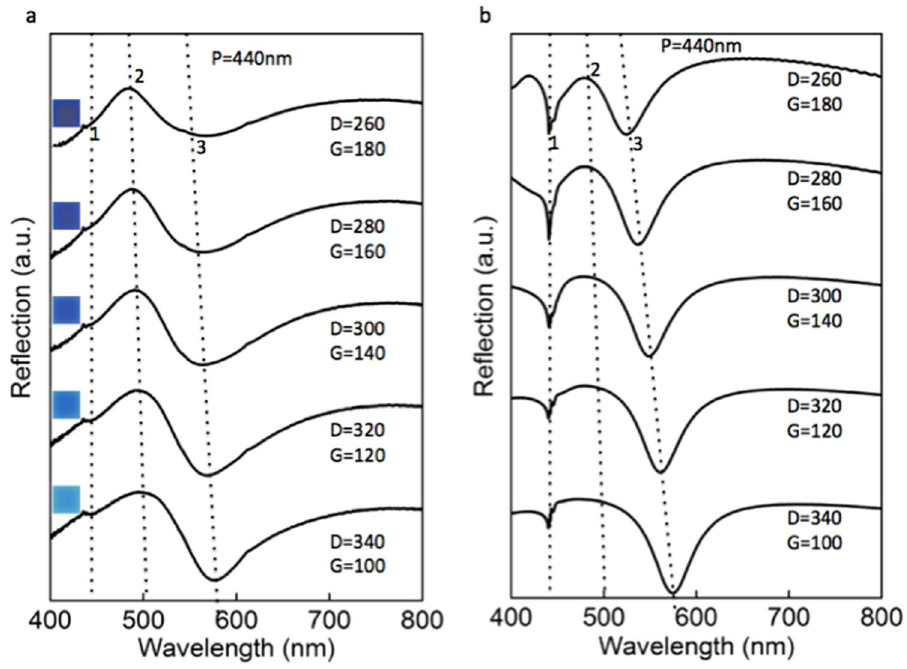
Figure 4. Tuning the colour saturation. ( a ) Experimental reflectance of the structures of same P with varying G and D. The gap size G was varied from 100 nm to 180 nm with an increment of 20 nm within the same pixel size P of 440 nm. Increasing G effectively reduces the square size D keeping P constant. As indicated by the dashed lines the resonance Dip2 at position 3 shifts towards the resonance Dip1 at position 1, which is invariant for changing G and D within the same P. This blue shift of the resonance Dip2 resulted in the spectral narrowing of the reflection peak R peak . The respective colours of the pallets shown in the inset of Fig. 4a confirmed the increasing colour saturation with increasing G, which in turn provides a means for tuning the colour saturation. ( b ) The corresponding simulated spectra of the structures show good agreement with the measured